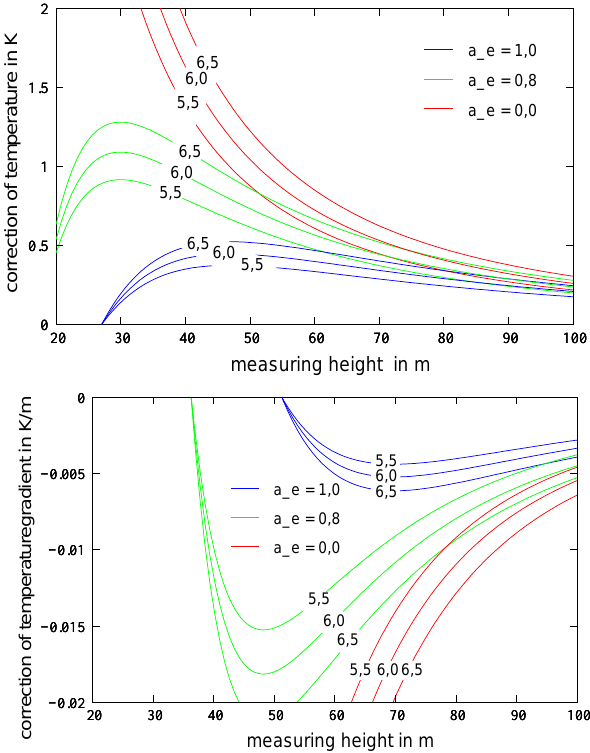
a e D Fig. 3. RASS temperature correction versus height after Kon for and .Theline- olor